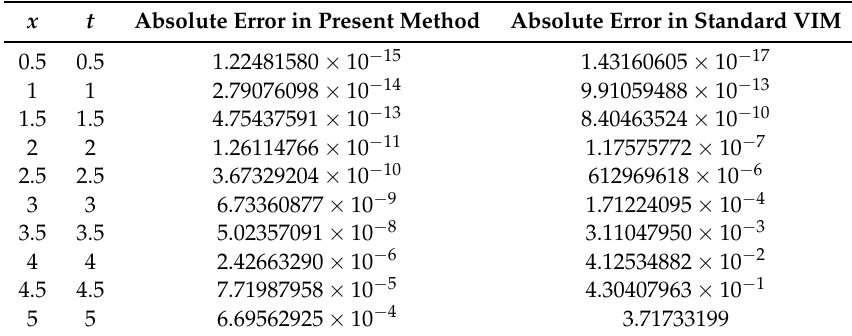
Table 3. Comparison of absolute errors for 16th-order approximation by present method with h = 1.1422 and standard VIM, when α = 0.9 in Example 1.